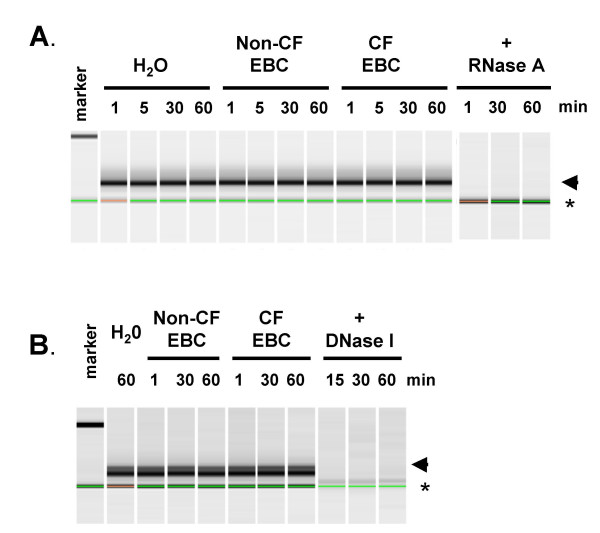
Stability of siRNA and asODN in exhaled breath condensate (EBC). siRNA (A) or asODN (B) were incubated for one to 60 min in water or EBC from CF and non-CF individuals. Oligonucleotide integrity was assessed using the Agilent Bioanalyser 2100 system. In control reactions siRNA and asODN were incubated with RNase A and DNase I, respectively, for one to 60 min. Arrowhead indicates oligonucleotides. Asterisk indicates lane marker.